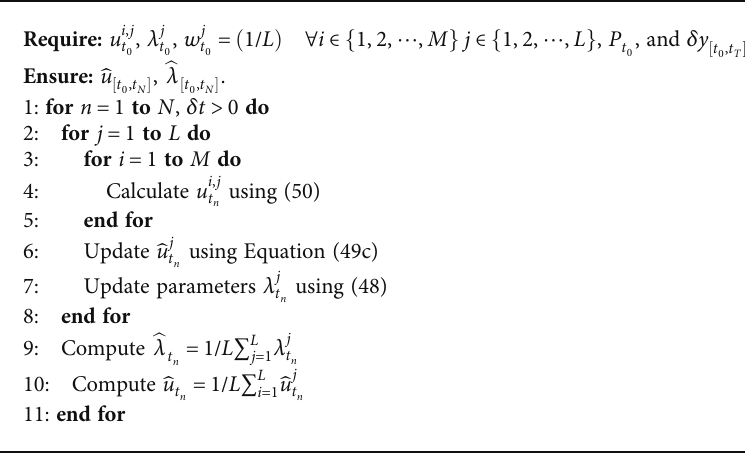
Algorithm 5: EnKBF dual fi